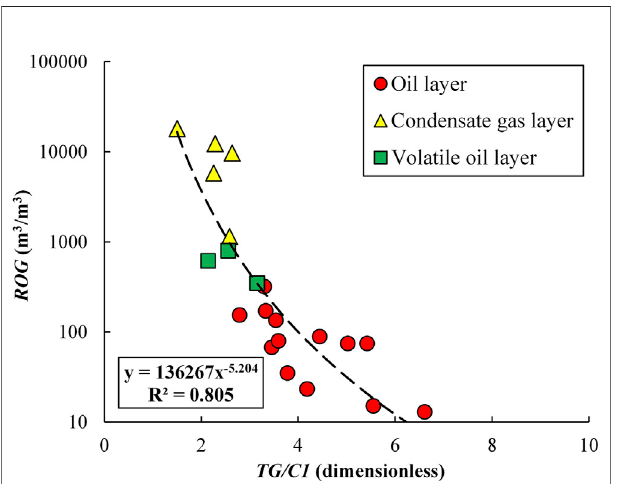
FIGURE 2 | The histogram of Tg/C1 and (C1 + C2)/(C3 + C4 + C5) corresponding to different hydrocarbon types in O oil fi eld.